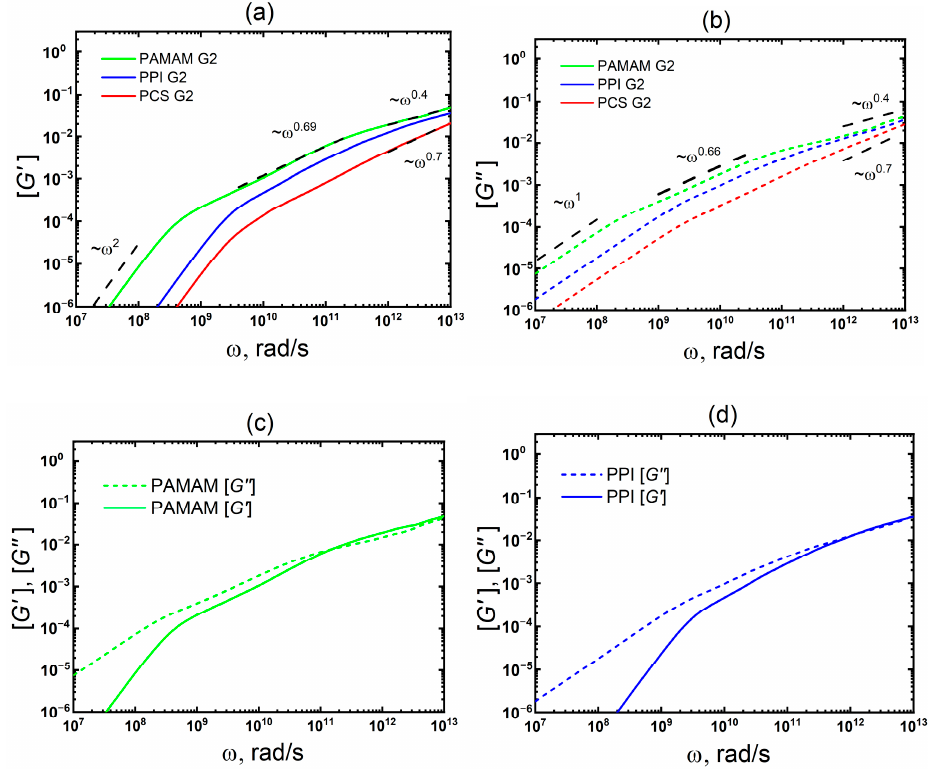
Figure 5. Double-logarithmic representation of the storage [G ′ ( ω )] ( a ) and loss [G ″ ( ω )] ( b ) moduli for PAMAM and PPI melts are plotted together; ( c , d ) separately for PAMAM and PPI, respectively. For comparison the data for PCS melt are adapted with permission from Ref. [40]. 2019, American Chemical Society.